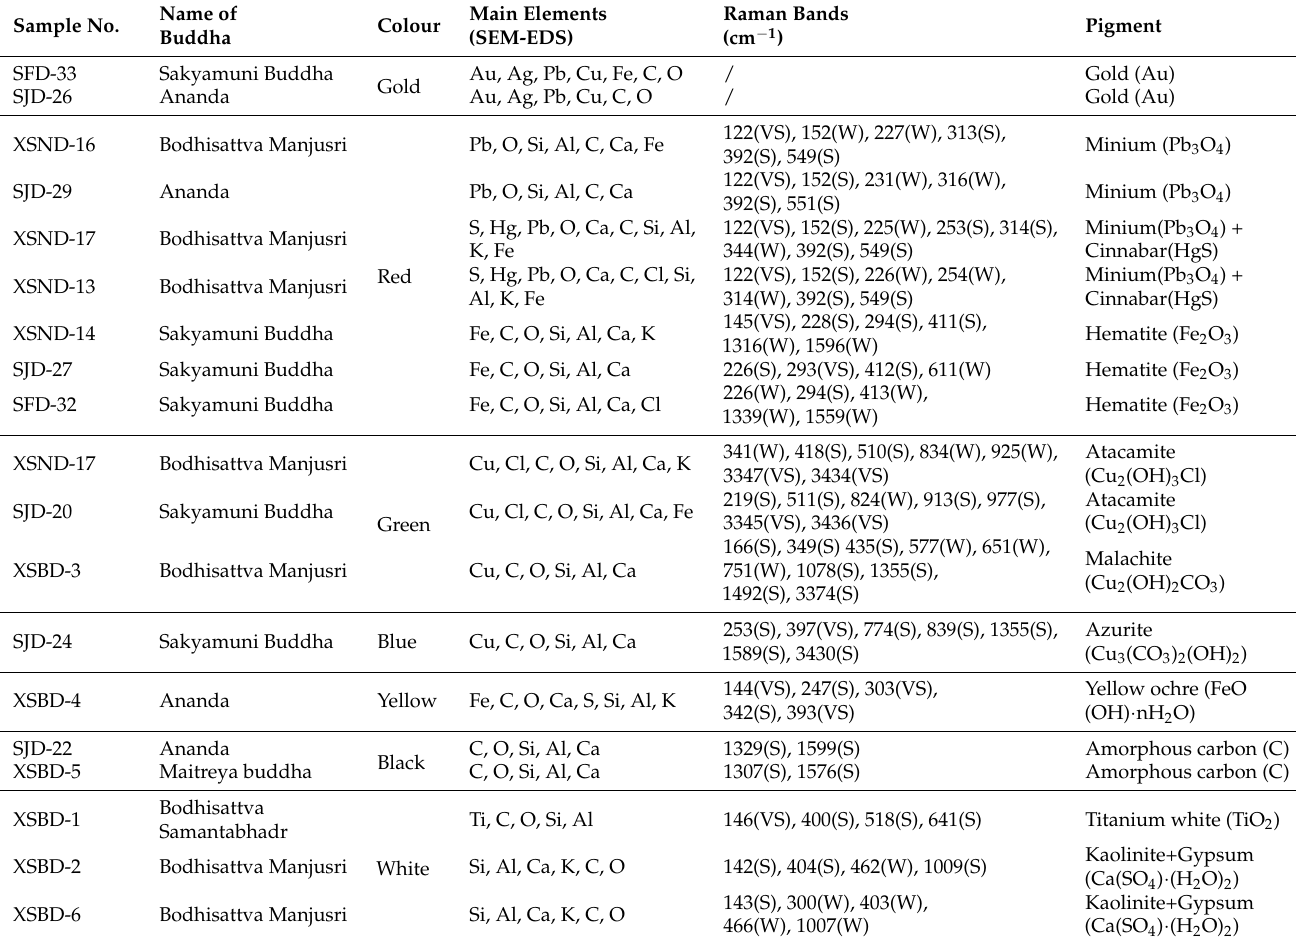
Table 3. Analysis of major colour pigments in the sculptures: VS (very strong), S (strong) and W (weak) represent the relative intensity of the Raman